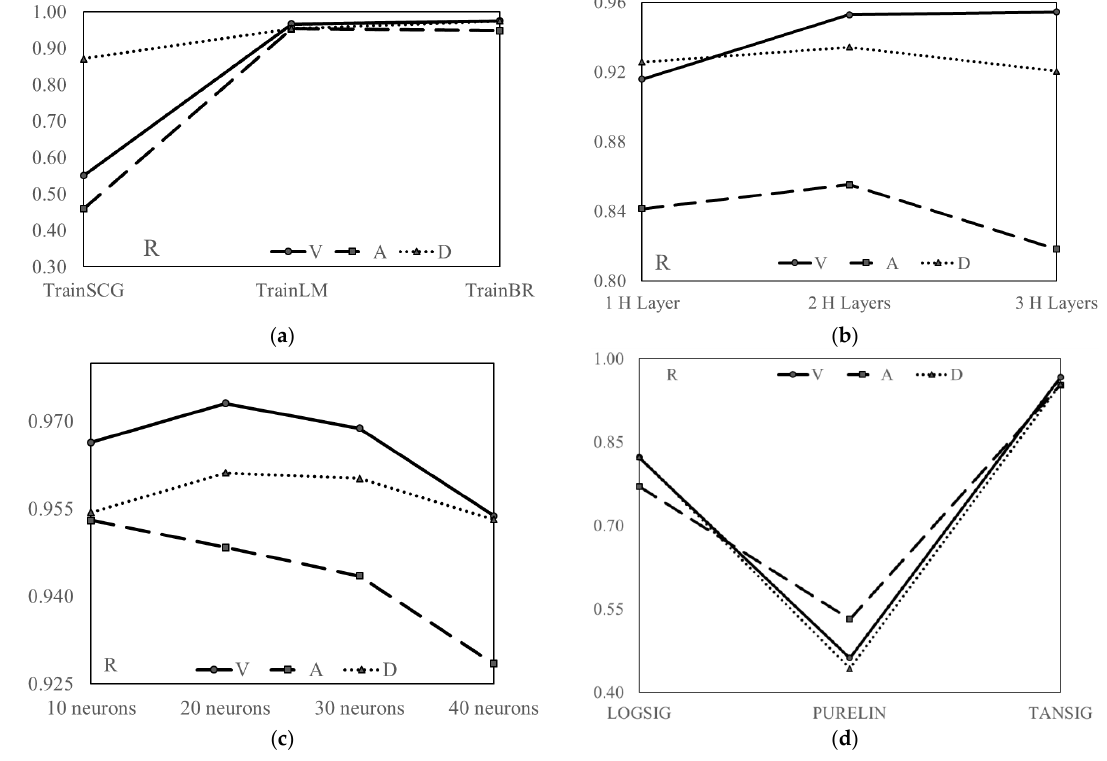
Figure 6. The effect of different parameters on the performance of the ANN. ( a ) Effect of the algorithm. ( b ) Effect of the number of layers. ( c ) Effect of number of neurons. ( d ) Effect of the type of function.